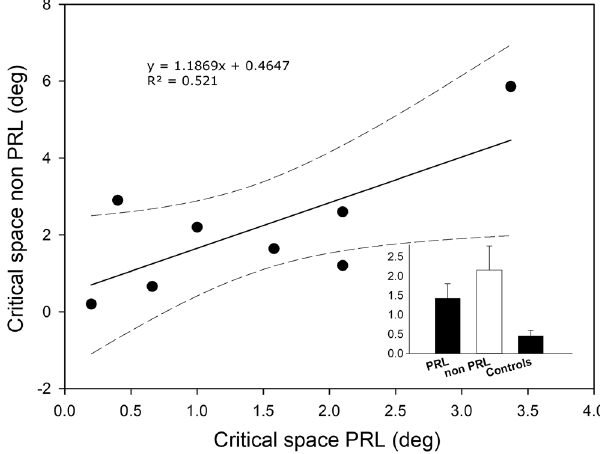
Figure 6. Scatter plot represents critical spacing for crowding obtained with stimuli presented at the non-PRL regressed on critical spacing for crowding obtained with stimuli presented at the PRL only for the patients for which the two positions were symmetrical with respect to the fovea. Dashed lines represent 95% confidence intervals. Average critical spacing for crowding for this subgroup (n = 8), and for the control group (n = 7) is also shown in the bar